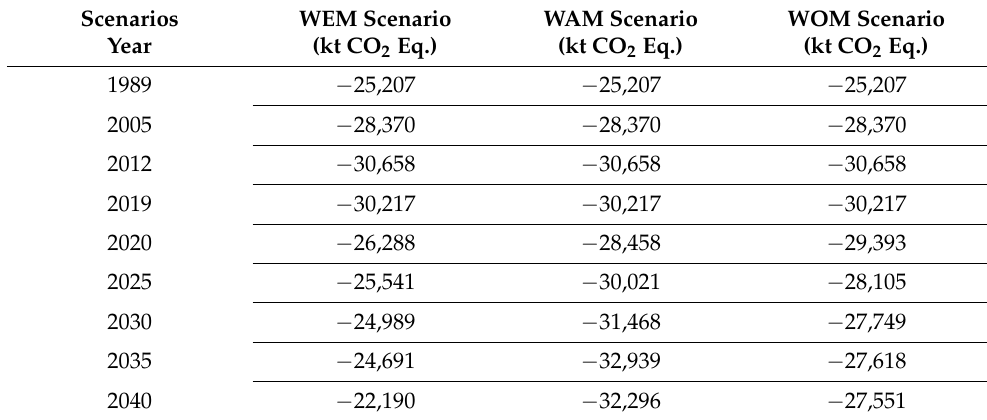
Table 6. Romanian’s LULUCF sector GHG emissions/removals evolution, by